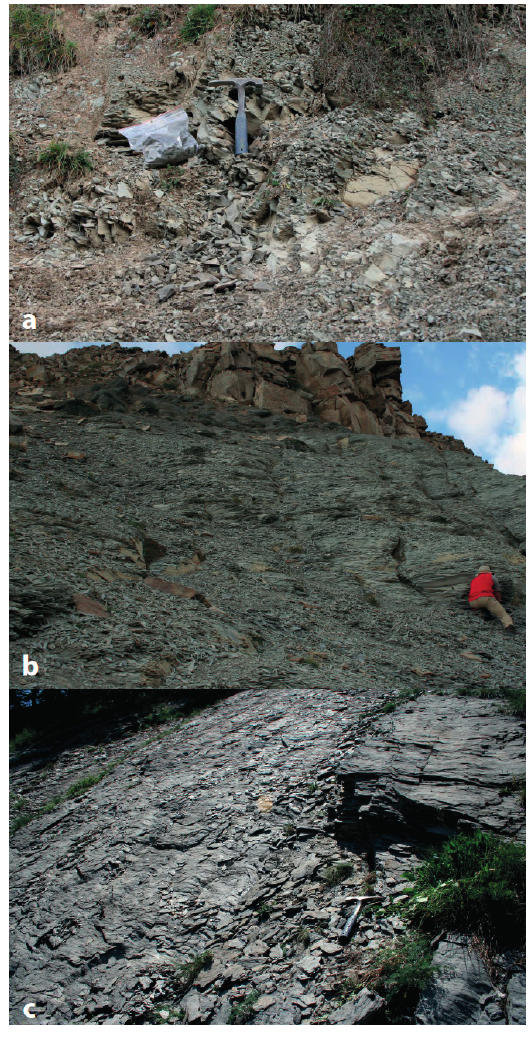
Figure 2. Outcrop views of the Marnes Bleues at Le Ruch ( a ), Grand Coyer ( b ) and Gias Vallonetto ( c ), located in Figure 1 as RU, GC and GV, respectively. Note the increasing fissility from rough scaly fabric in ( a ) to pencil cleavage in ( b ) to crenulation cleavage in ( c ), related to increasing compaction and burial temperature from ( a ) to ( c ) (Figure